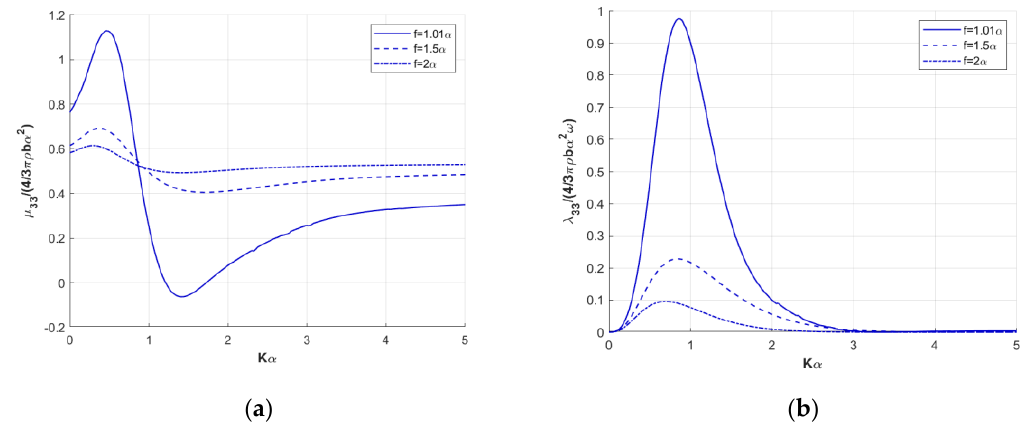
Figure 6. E ff ect of immersion, f , on the normalized heave hydrodynamic coe ffi cients for an oblate Figure 6. Effect of immersion, 𝑓 , on the normalized heave hydrodynamic coefficients for an oblate spheroid of a / b = 1.1: ( a ) Heave added mass; ( b ) Heave hydrodynamic spheroid of 𝑎/𝑏 = 1.1 : ( a ) Heave added mass; ( b ) Heave hydrodynamic damping.